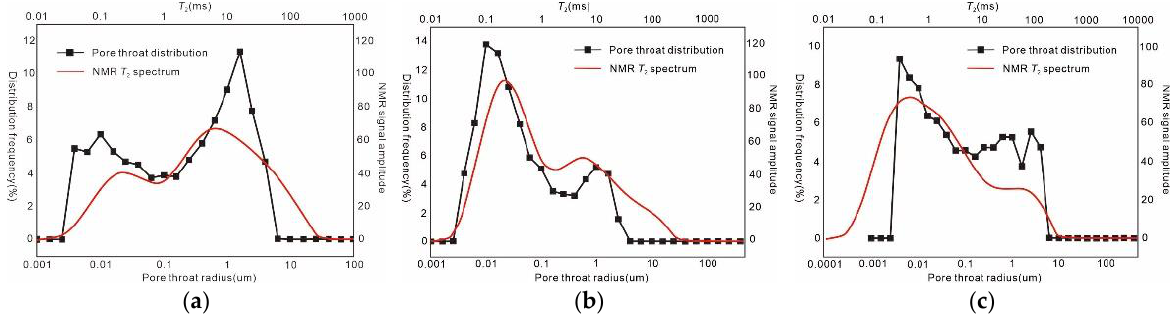
Figure 4. Comparison of pore throat radius and T 2 spectrum distribution characteristics of conglom- erate reservoirs from different well blocks. ( a ) Well Block Ma18. ( b ) Well Block Ma131. ( c ) Well Block Aihu2.